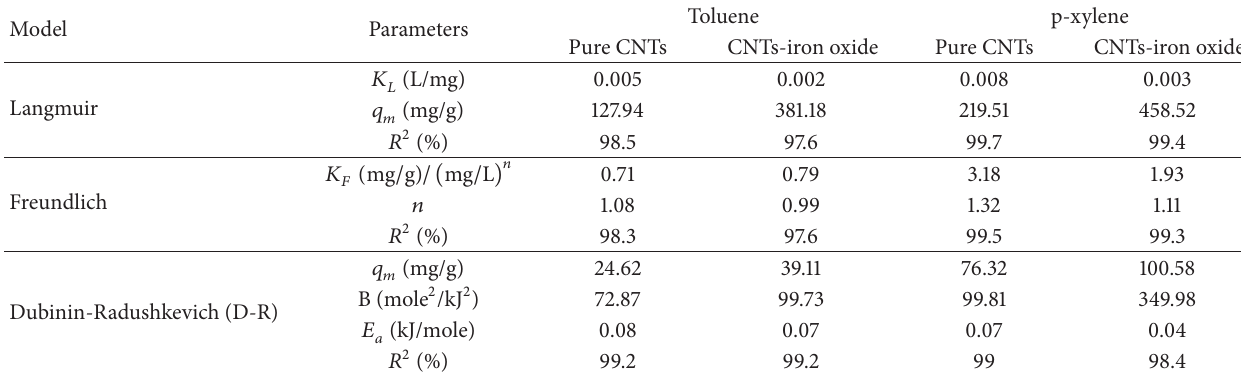
Table 3: Isotherm models parameters for toluene and p-xylene